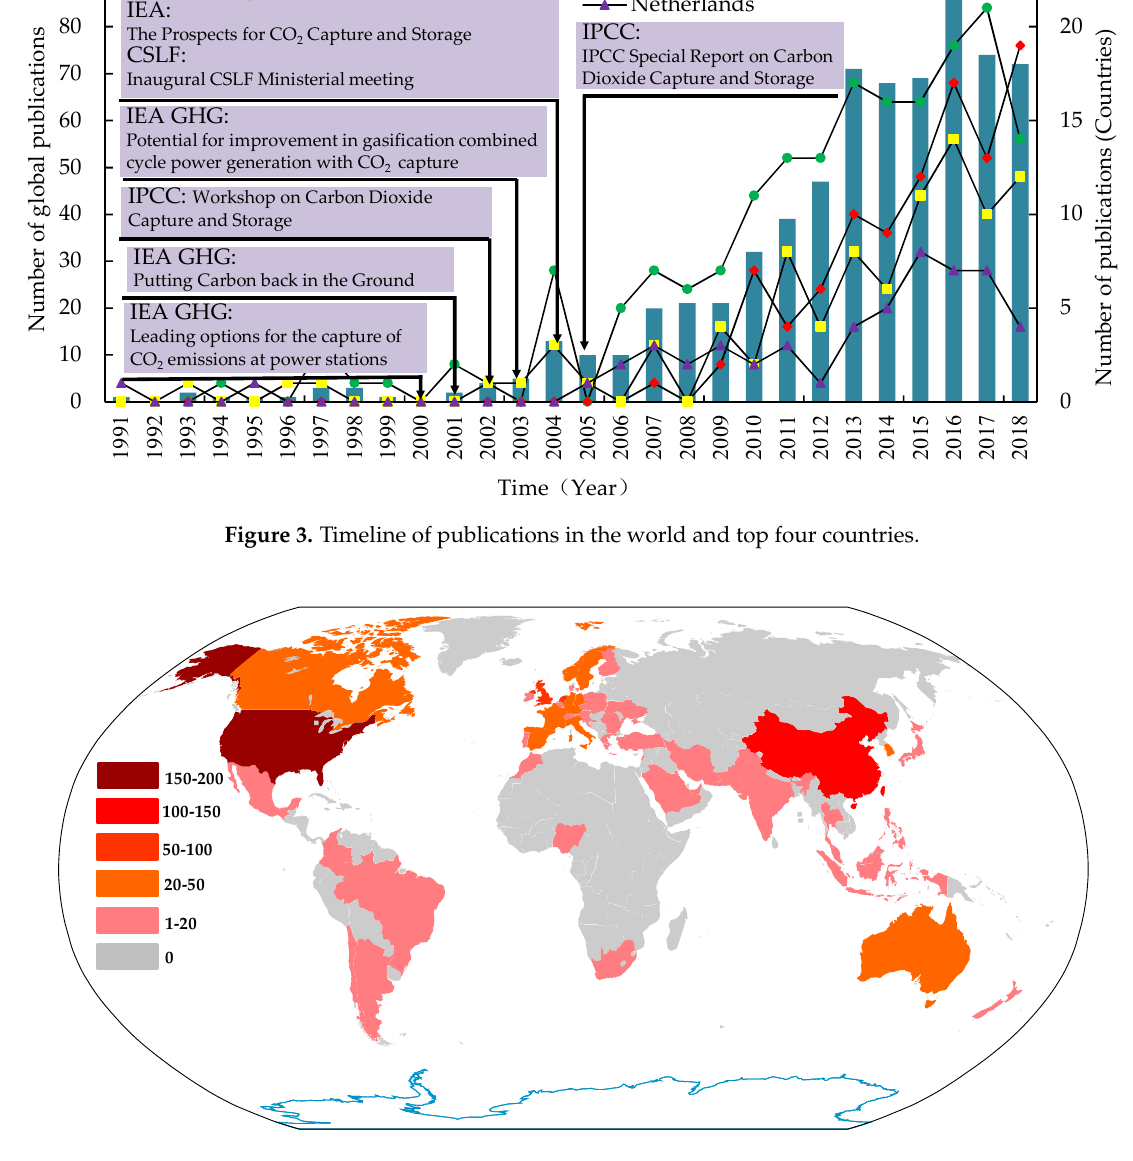
Figure 4. Geographical distributions of publications.